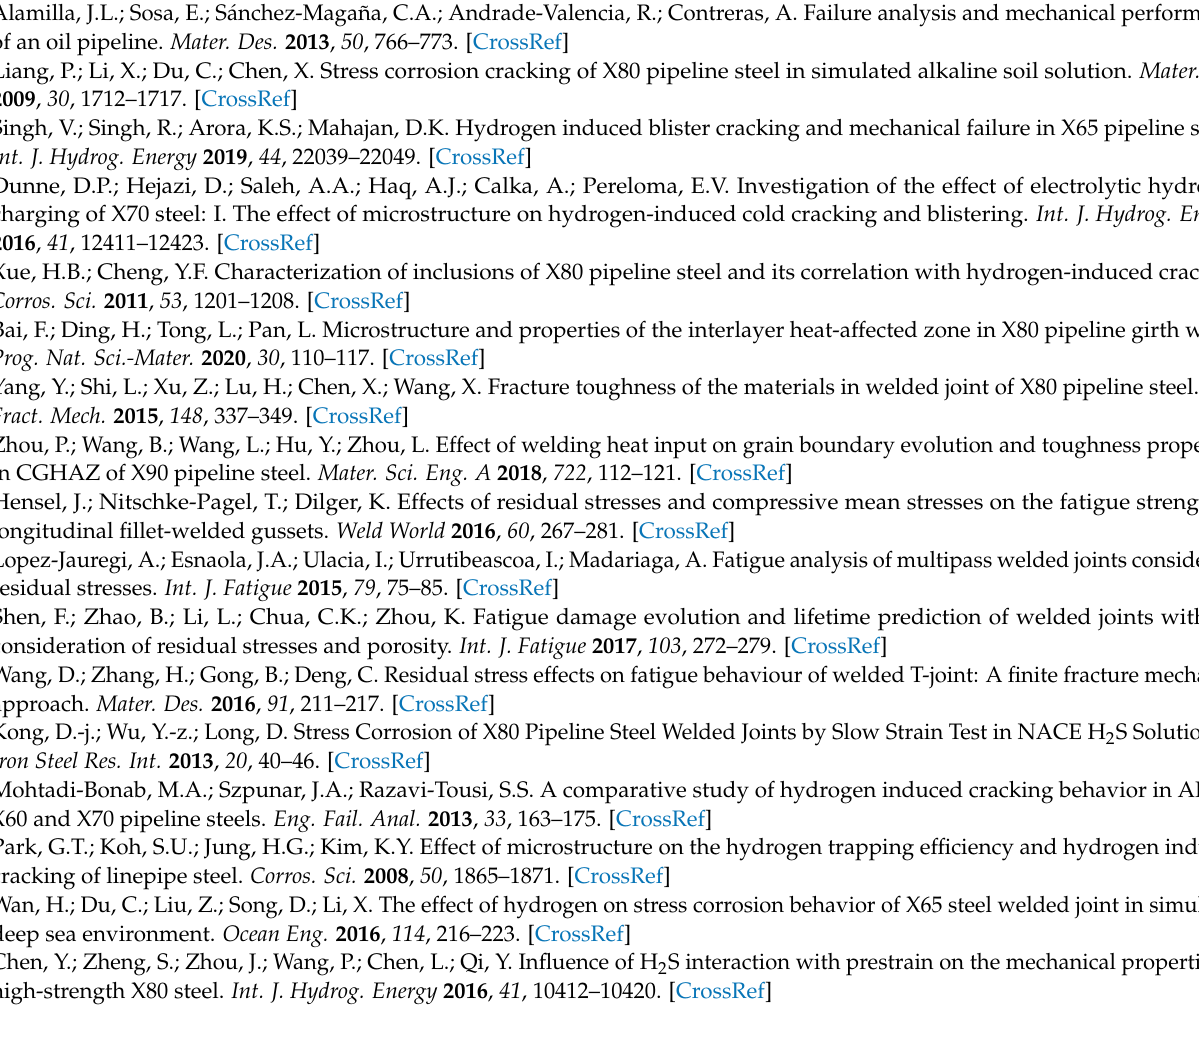
3. The cracks tended to propagate within GBF for WZ due to the lower H 2 S corrosion resistance of GBF. The microstructure of CGHAZ was mainly PF and GB, as well as some LB and M/A constituents. The lowest number of high angle grain boundaries and severe coarsening of grain size significantly reduced the crack propagation resis- tance for CGHAZ. The microstructure of the SCHAZ was homogeneous ferrite grains maintaining the rolling direction of the BM compared with the WM and CGHAZ, making SCHAZ exhibit better resistance to H 2 S corrosion and crack